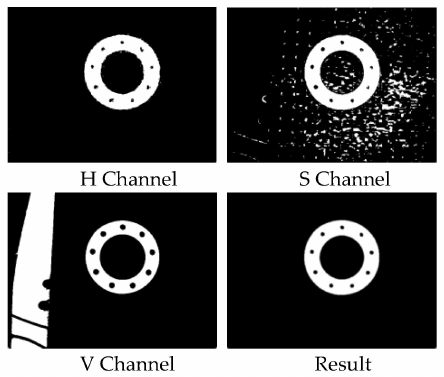
Figure 4. The extraction results of the petroleum pipeline interface.